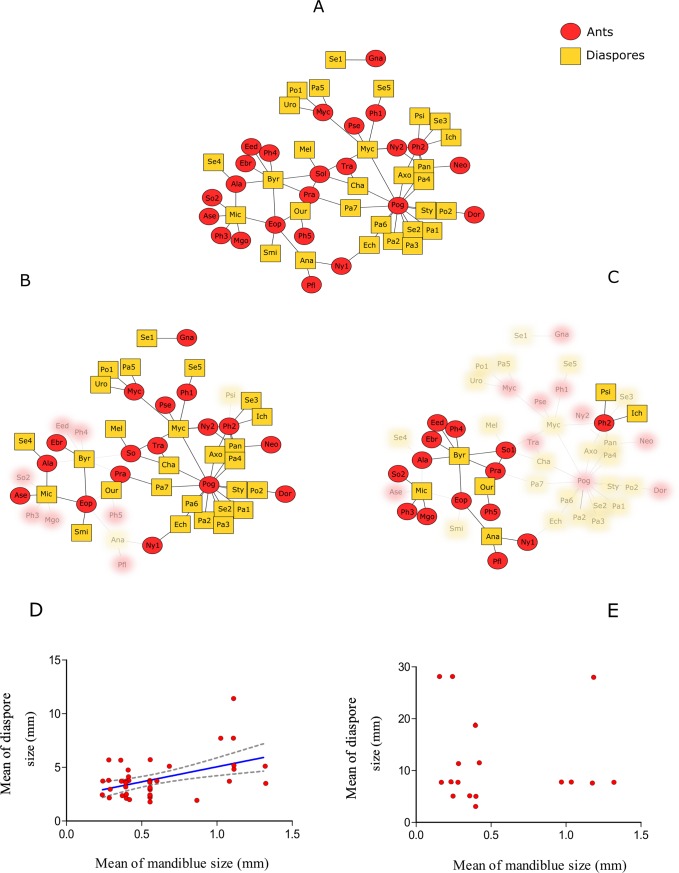
Ant–diaspore networks and the relation between the morphological traits.Ant–diaspore networks and relationship between the mandible size and diaspore size in the Brazilian Savanna involving three types of interactions: A) the total network; B) diaspore removal network; C) fruit consumption network. Within each network, nodes represent one plant species (yellow square) or ant species (red circle) and lines represent ant–diaspore interactions. Relationship between the mandible size of ants and the size of the diaspores on which they D) remove (F1,43 = 12.173, p < 0.01) and E) feed (F1,15 = 0.210, p = 0.886). The area between dashed lines represents the linear best-fit model (95% confidence intervals). Species name code are in S1 Table and S2 Table.